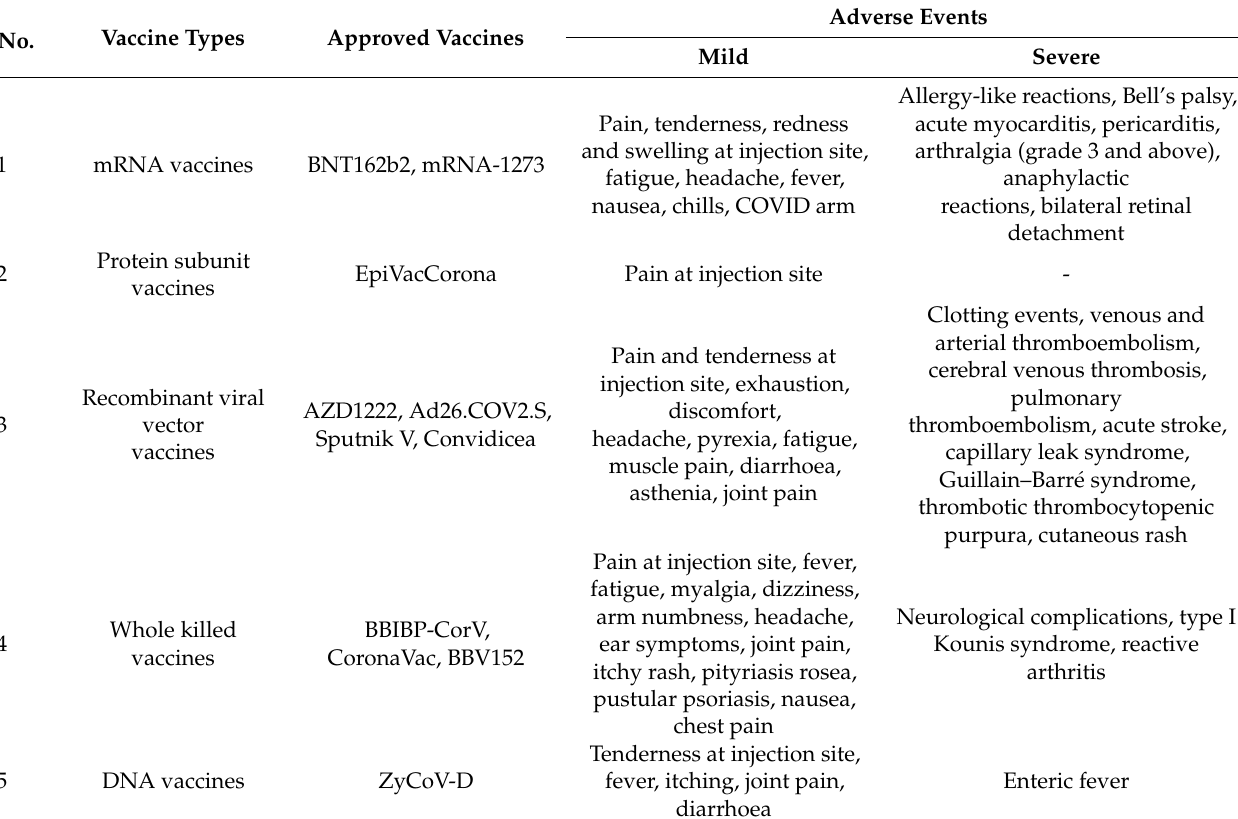
Table 4. Reported adverse effects of approved vaccines with respect to vaccine types. S.